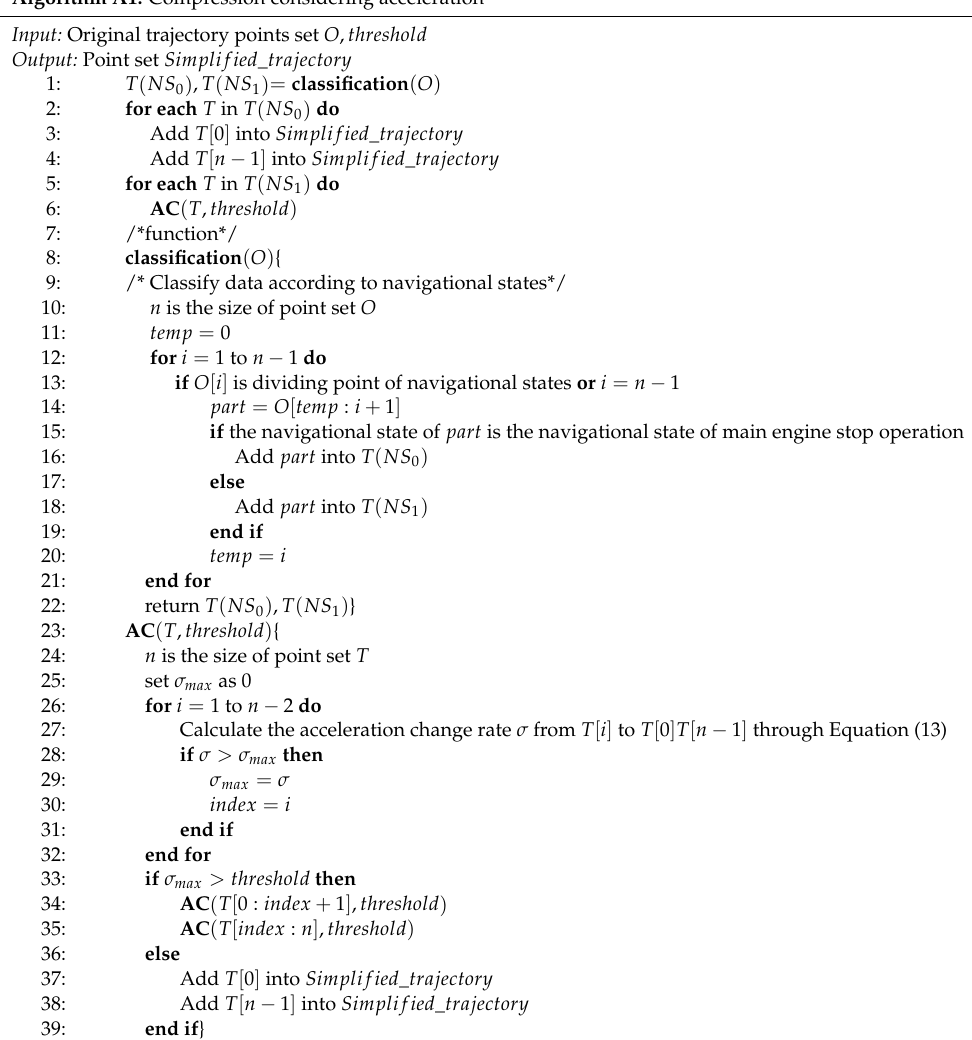
Algorithm A1. Compression considering